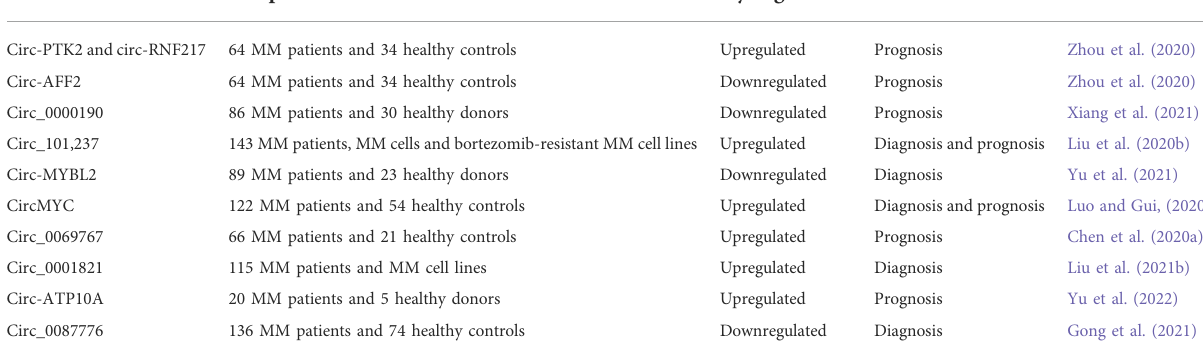
TABLE 1 CircRNAs as diagnostic and prognostic biomarkers for